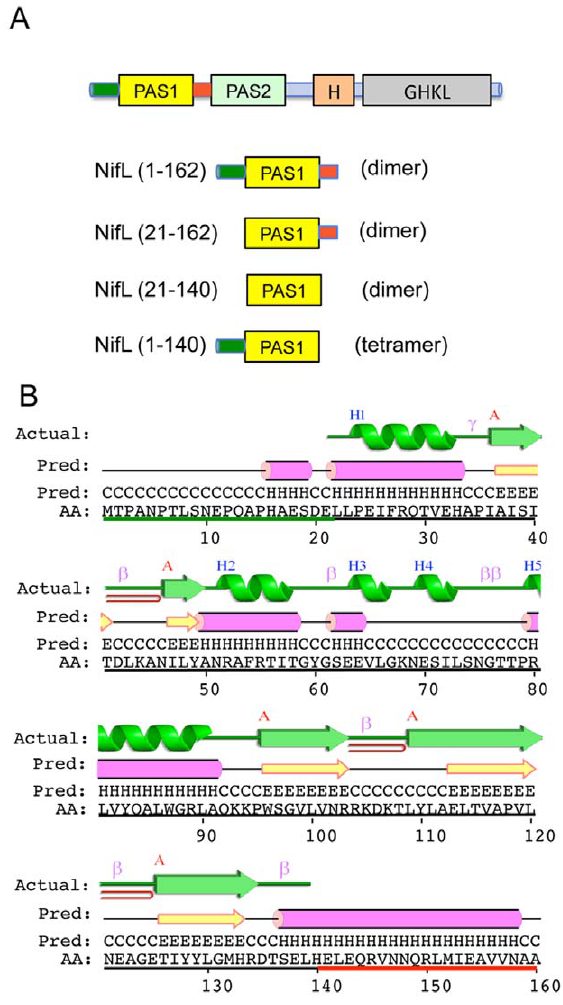
Figure 2. Structural features of the NifL PAS1 domain and its flanking regions. (A) Summary of NifL fragments used to analyse the influence of flanking regions on the properties of the PAS1 domain, indicated below the domain architecture of the complete protein. The oligomerisation state of each fragment, as determined by size exclusion chromatography in this work, is indicated in brackets. (B) The predicted secondary structure of NifL residues 1–160 as determined by the PSIPRED server [18] is shown above the amino acid sequence. Amino acids resolved in the crystal structure of the oxidized form of PAS1 [13] are underlined in black. The secondary structure plot for PDB code 2gj3: chain A (from PDBsum [30]) is displayed above the predicted structure. N-terminal and C-terminal flanking sequences are underlined in green and red respectively.